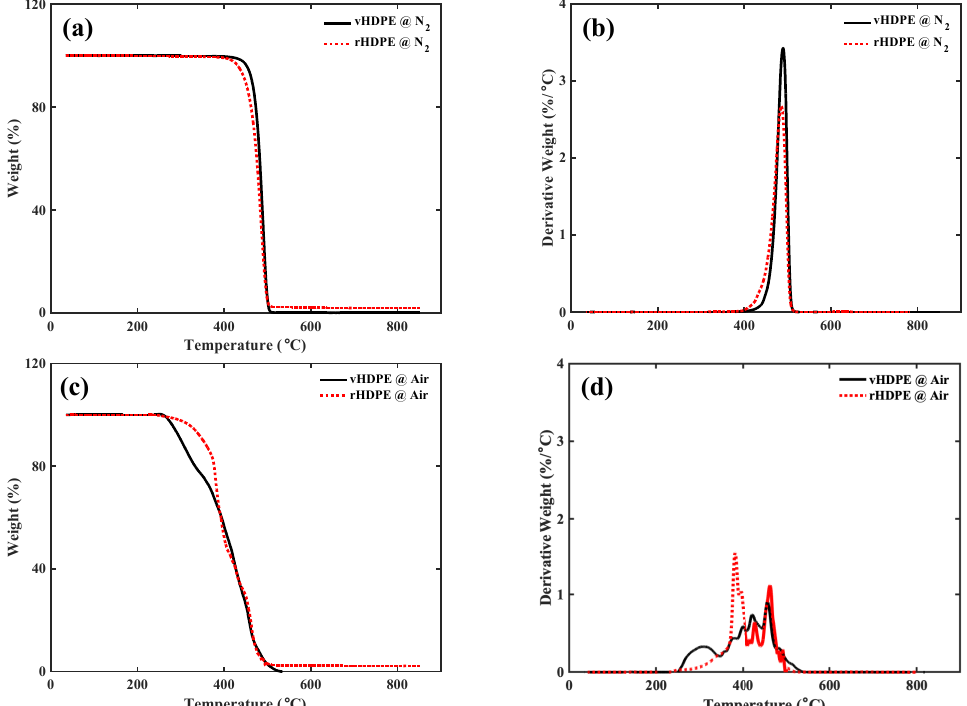
Figure 3. Weight curves and their derivative as a function of temperature for v/rHDPE in: ( a , b ) nitrogen and ( c , d ) air.